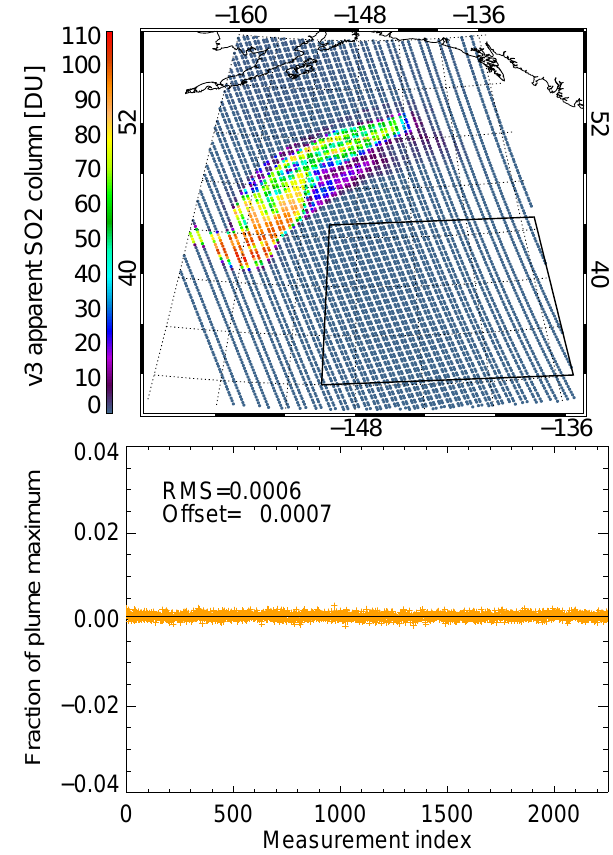
Fig. 7. The plume of SO 2 for the morning overpass on 10 Au- gust 2008 using the ν 3 band filter for Method (2) as described in the text using the modelling approach to compute S tot (cid:15) . Fractional varia- tion in the background normalised according to the maximum value within the plume (108DU) shown in the bottom panel for IFOV’s inside box. Reported 1 σ sensitivity ( σ c ) for this filter of 0.0012 (=0.126DU). Observed RMS of background=0.0019. Expected climatological value shown as red line. Mean value of background value shown as black line.